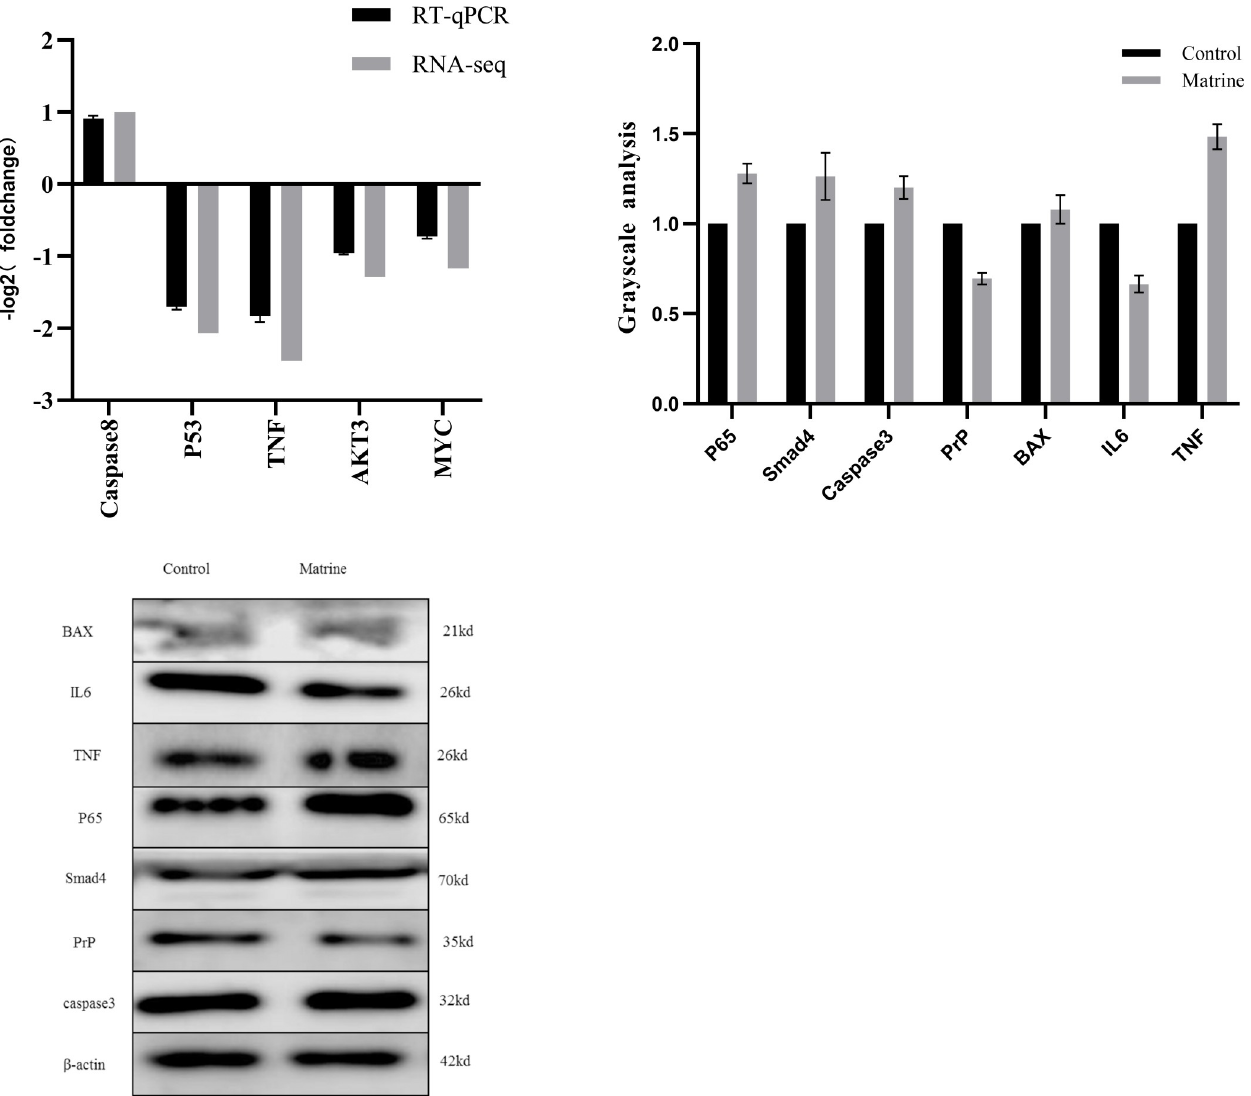
Fig 4. The DEGs were verified by qPCR and the effect of matrine on the expressions of apoptosis-related proteins was measured by western blotting. A. Comparison of the relative expression of DEGs screened by RT-qPCR and RNA-seq for the matrine-treated group. B. matrine-treated group immunoblots showing expression levels of BAX, IL6, TNF, Caspase3, P65, Smad4, and PrP. C. Gray-scale analysis of matrine-treated group showing expression levels of BAX, IL6, TNF, Caspase3, P65, Smad4, and PrP.